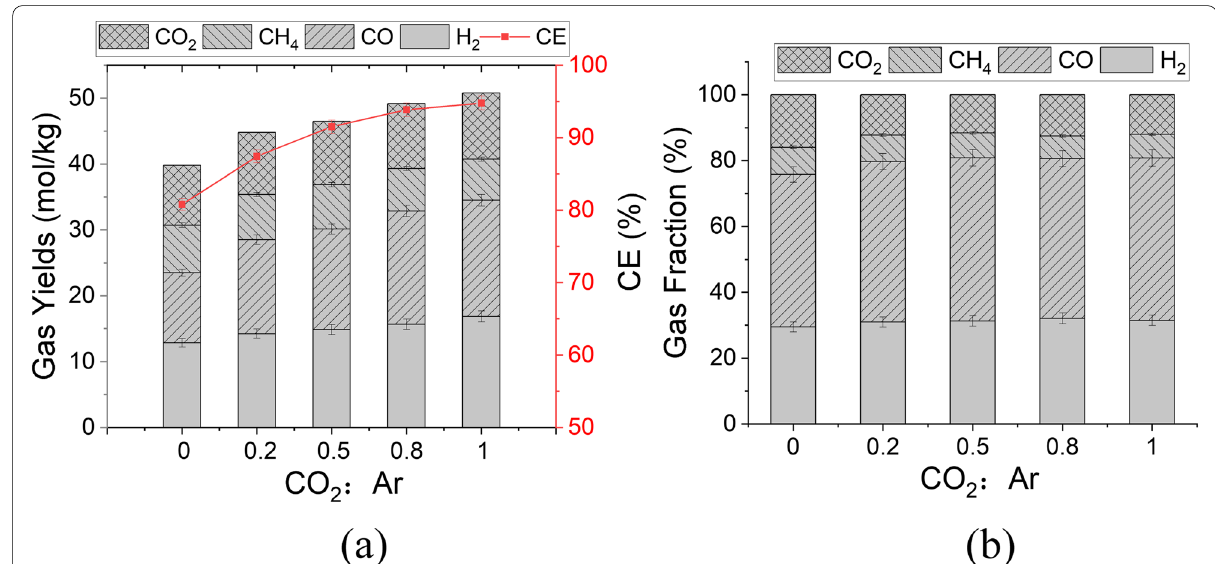
Fig. 5 Effect of the amount of CO 2 on the supercritical carbon dioxide gasification of biomass (900 °C; 30 min; K 2 CO 3 : Biomass yields of biomass gasification; b composition of the gas